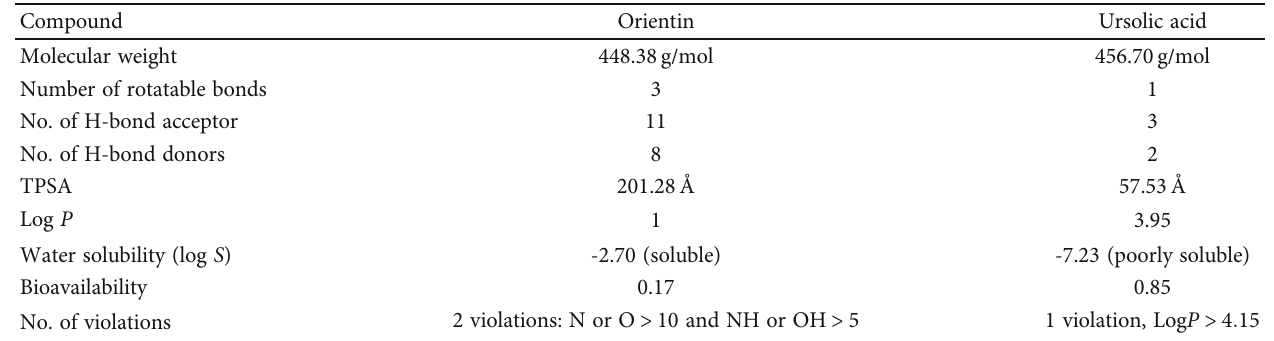
Table 4: Druglikeness properties of orientin and ursolic